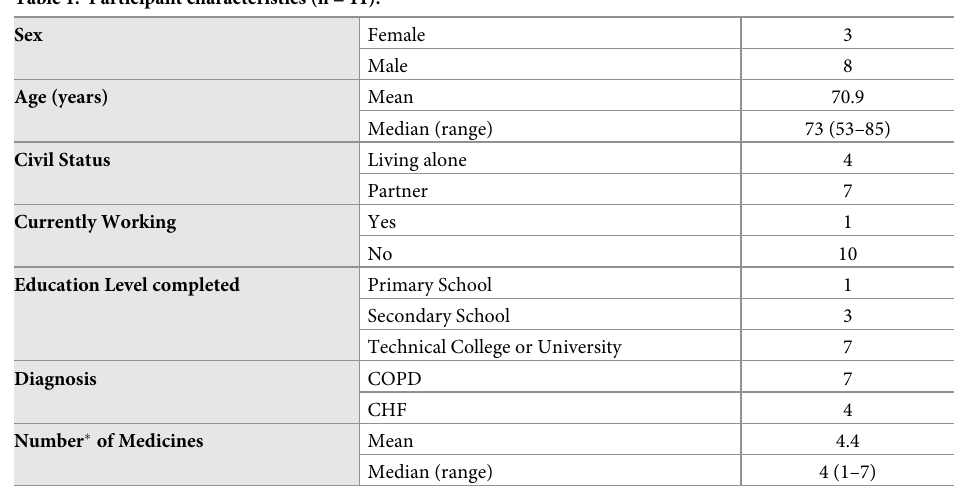
Table 1. Participant characteristics (n =